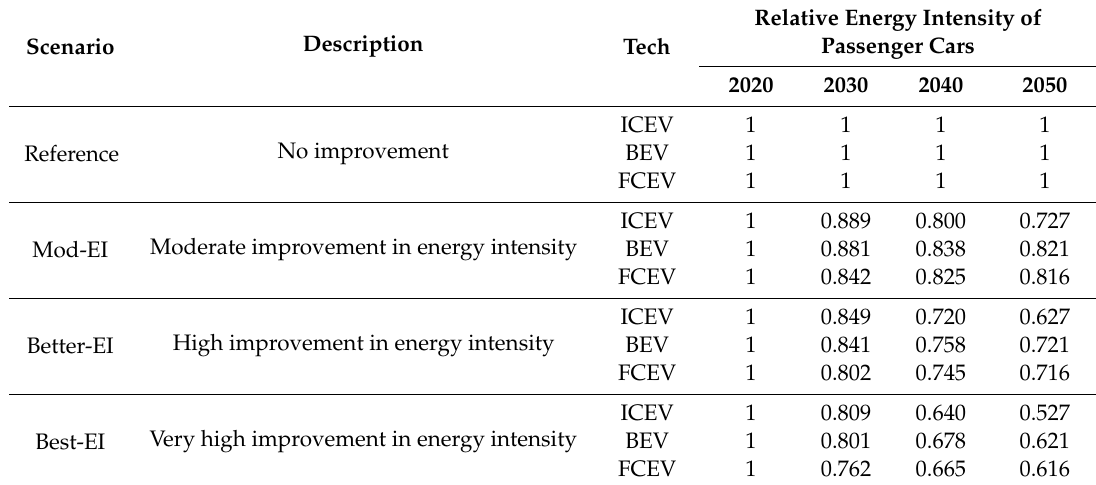
Table 1. Energy intensity improvement scenarios (unit: